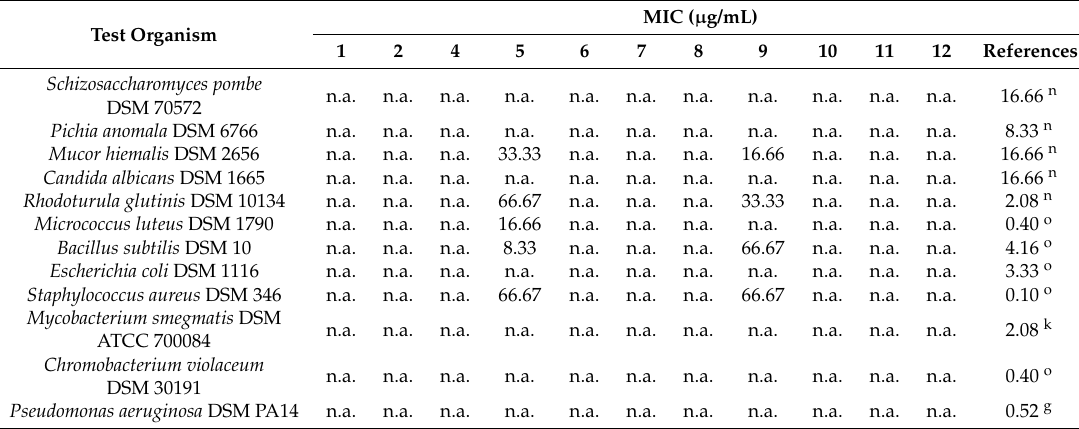
Table 3. MIC [ µ g/mL] values of Compounds 1 , 2 , 4 – 12 against the tested microorganisms. Test Organism